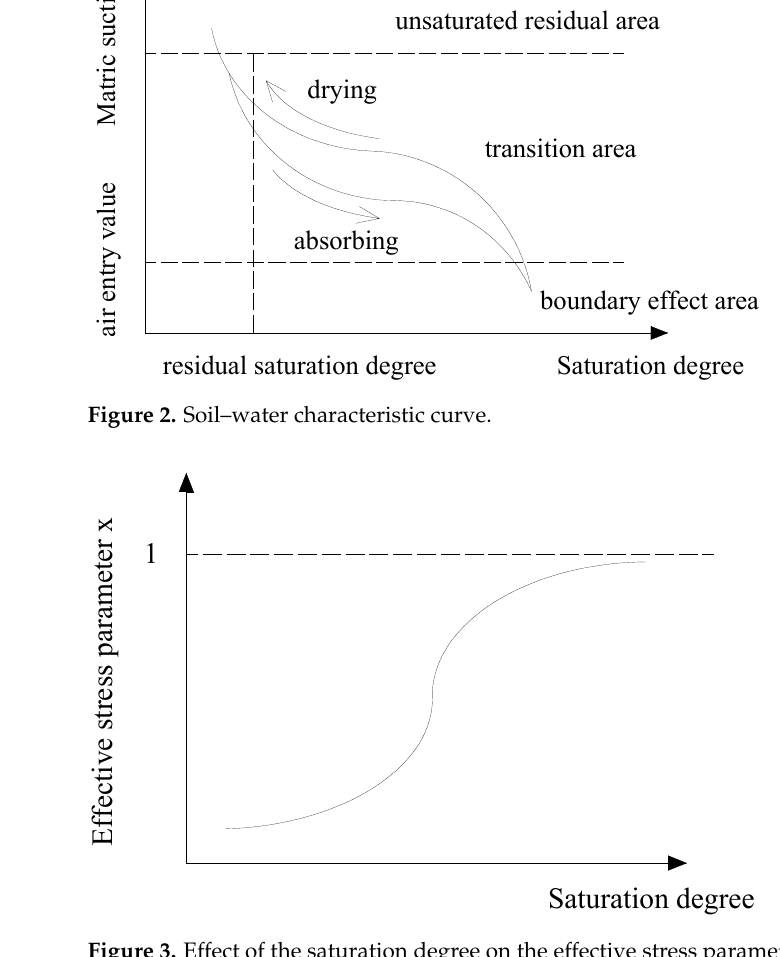
Figure 3. Effect of the saturation degree on the effective stress parameter 𝜒 .